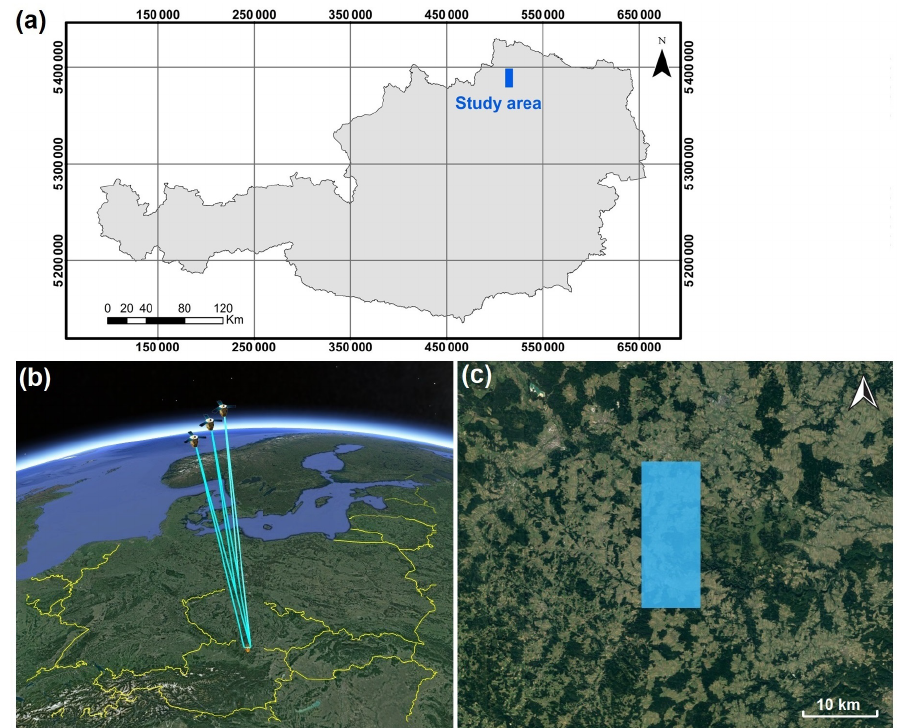
Figure 2. Satellite image acquisition for the study area: ( a ) Overview map of Austria with marked location of the study area (coordinates in UTM zone 33N). ( b ) Pléiades tri-stereo acquisition geometry (view of satellite positions in Google Earth). ( c ) Acquisition footprint visualized in Google